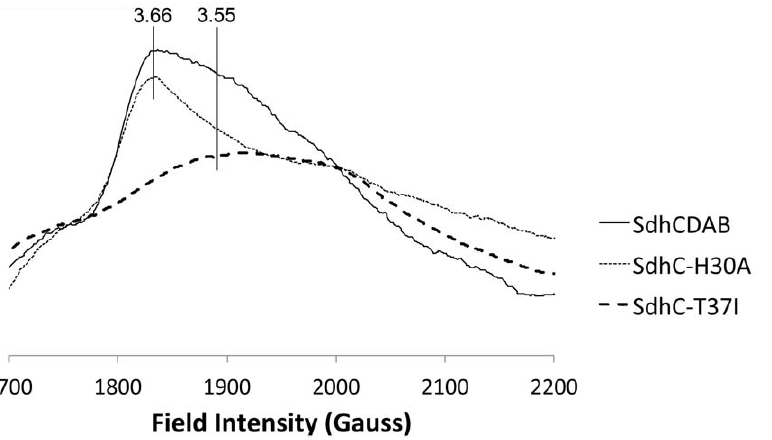
Figure 2. Ferric heme EPR lineshapes of the two heme conformations. The signal in wild-type Sdh is a mixture of a sharp and broad species, exemplified in the SdhC H30A and SdhC T37I variants, respectively.